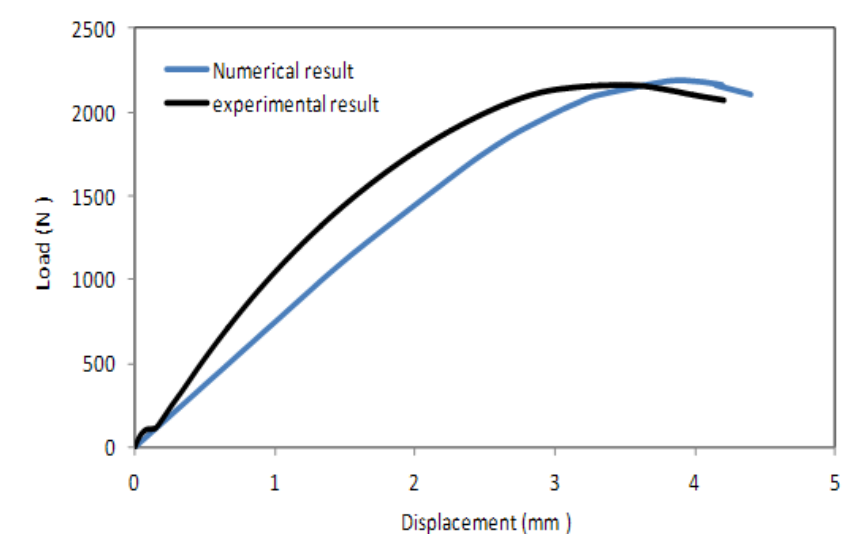
Figure 14: mechanical behavior of lap shear joints by